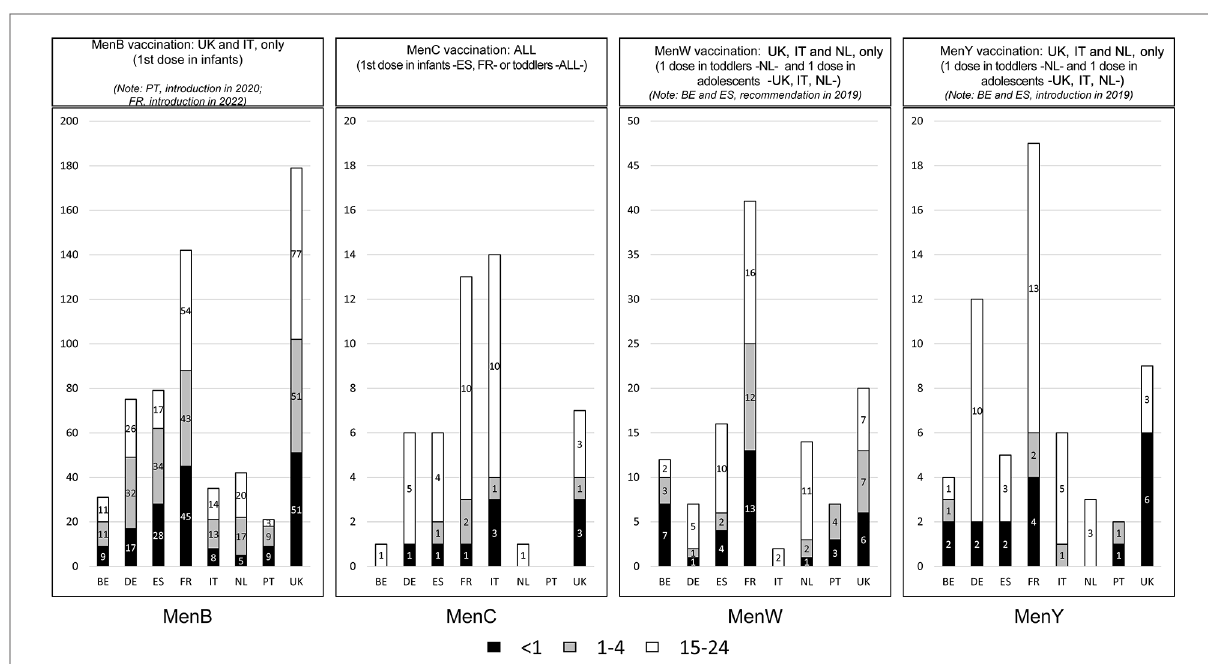
FIGURE 3 Number of IMD cases in infants, toddlers, and young people (15 – 24 years) in 2019 by country and serogroup. BE, Belgium; DE, Germany; ES, Spain; FR, France; IMD, invasive meningococcal disease; IT, Italy; NL, Netherlands; PT, Portugal; UK, United Kingdom. For each serogroup, information on vaccination with monovalent MenB vaccine, monovalent MenC vaccine, or quadrivalent MenACWY vaccine is provided for each